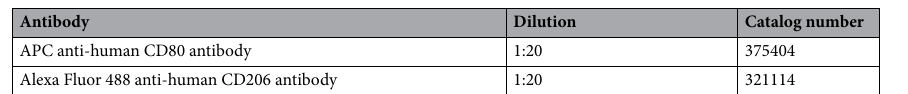
Table 2. Fluorescent conjugated antibodies used in flow cytometry analysis. All antibodies were manufactured by BioLegend.